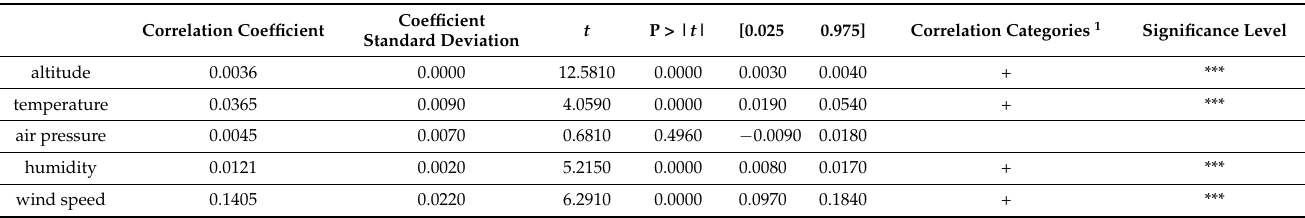
Table 4. The correlation performance of each feature when the dependent variable is average paddle frequency difference of